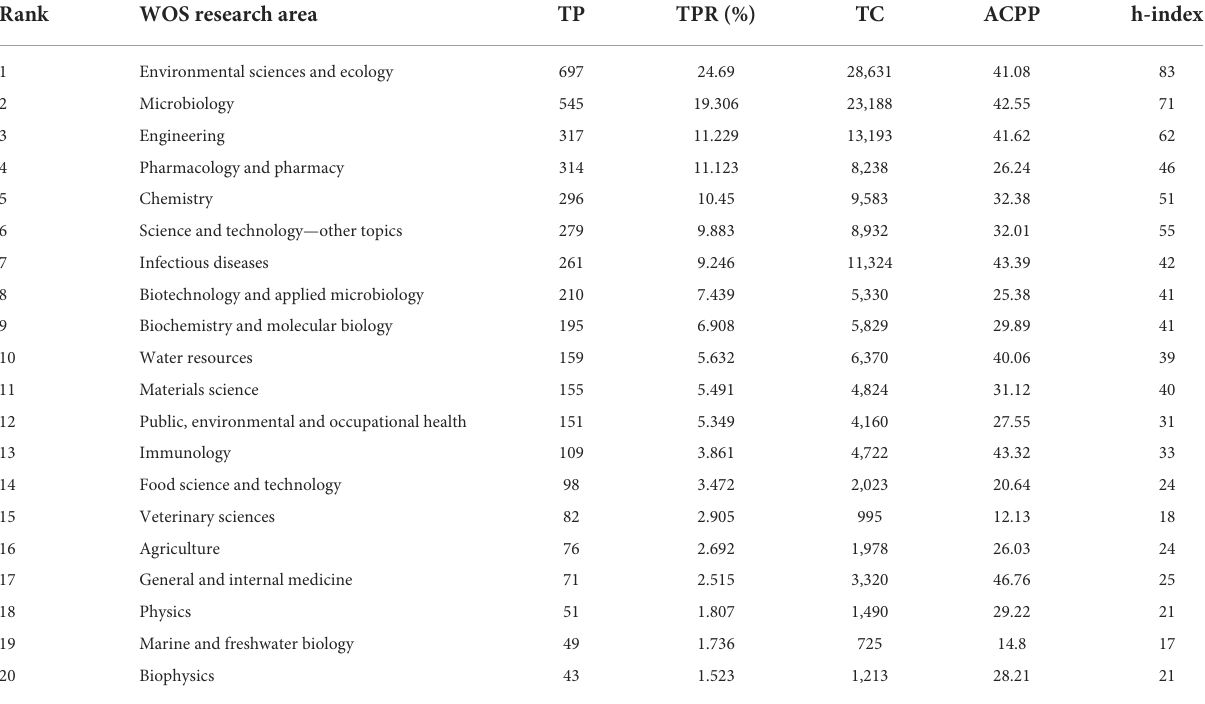
TABLE 5 Contribution of the top 20 research areas in ARB